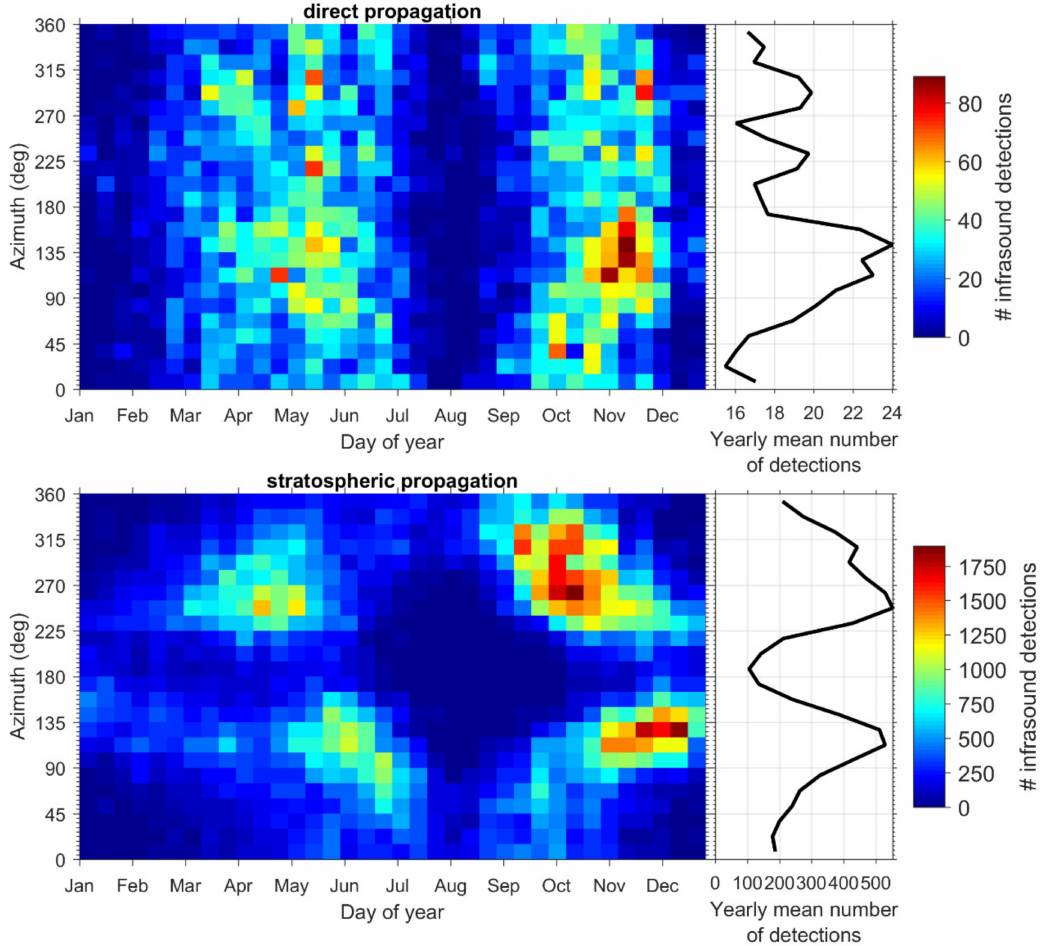
Figure 6. Distributions of the number of infrasound detections associated with WWLLN flashes for a tropospheric ( top ) or stratospheric ( bottom ) propagation in function of their azimuth and day of year of occurrence (15 ◦ × 10 days bins). The yearly mean number of detections vs. the azimuth is plotted on the